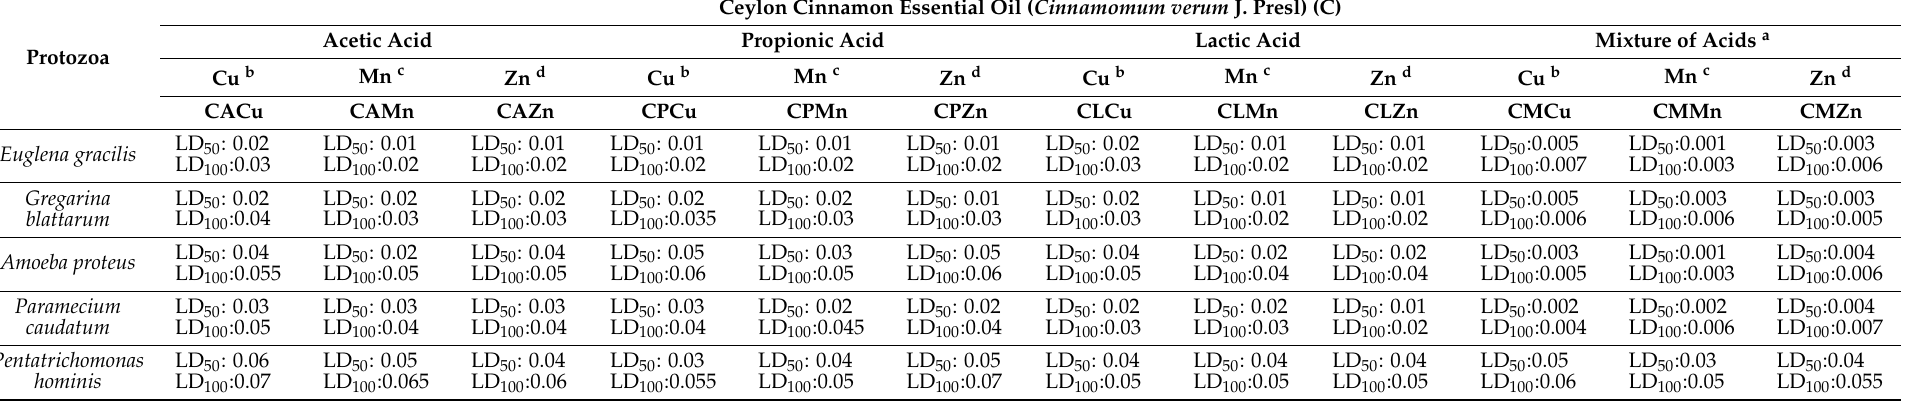
a —chloramphenicol, b —metronidazole, c —in rate 1:1:1, d —Manganese (II) chloride 10% solution, e —Copper (II) carbonate hydroxide 10% solution, f —Zinc carbonate 10% solution, g —5% solution, n.t—not tested. Table 7. LD 50 , LD 100 values [%] for the tested mixtures of Ceylon cinnamon essential oil ( Cinnamomum verum J. Presl) (C), organic acids (Acetic acid—A, Propionic acid—P, Lactic acid—L, Mixture of acids—M) and metal ion against selected protozoa. Ceylon Cinnamon Essential Oil ( Cinnamomum verum J. Presl) (C) Protozoa